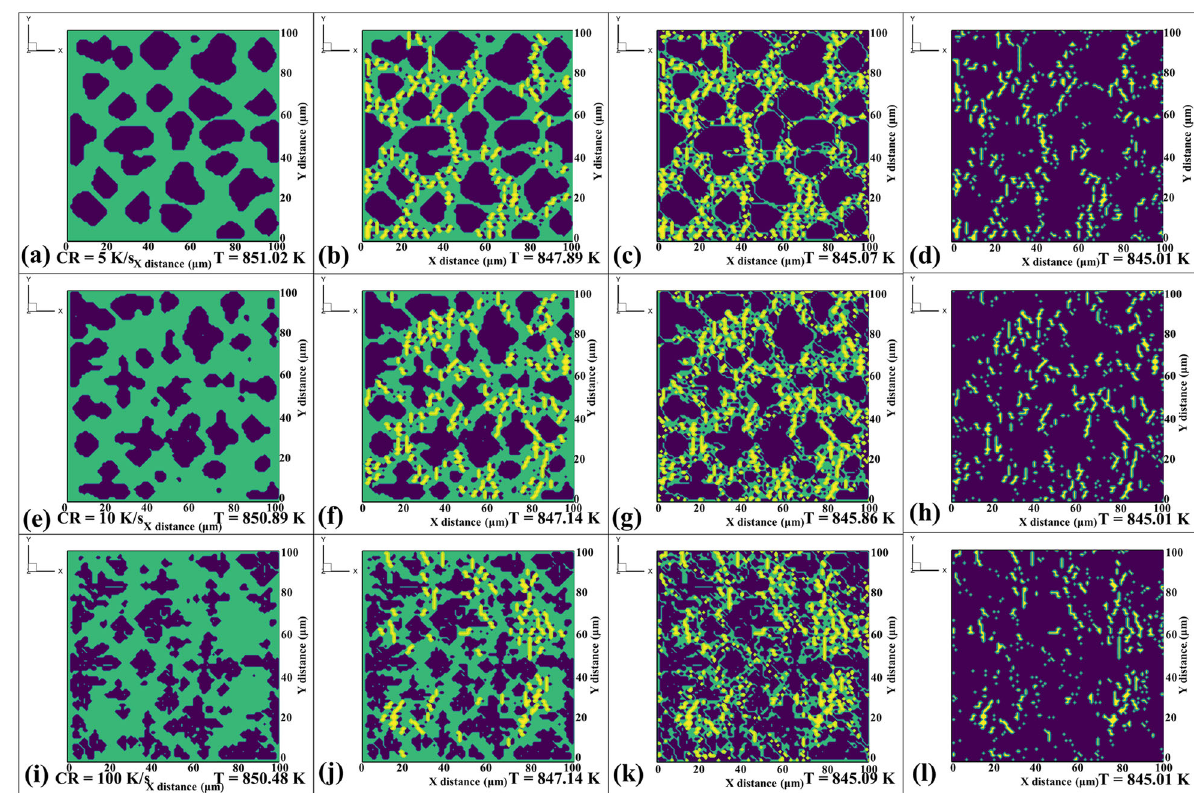
Fig. 4 2-D cross-sections of 3-D simulation results. 2-D cross-section of a 3-D simulation result, with the cooling rate of 5 K s − 1 at a 851.02 K, b 847.89 K, c 845.07 K, and d 845.01 K, with the cooling rate of 10 K s − 1 at e 850.89 K, f 847.14 K, g 845.86 K, and h 845.01 K, with the cooling rate of 100 K s − 1 at i 850.48 K, j 847.14 K, k 845.09 K, and l 845.01 K. ( α -Al is in blue color, Si is in yellow color, and the remaining liquid is in green